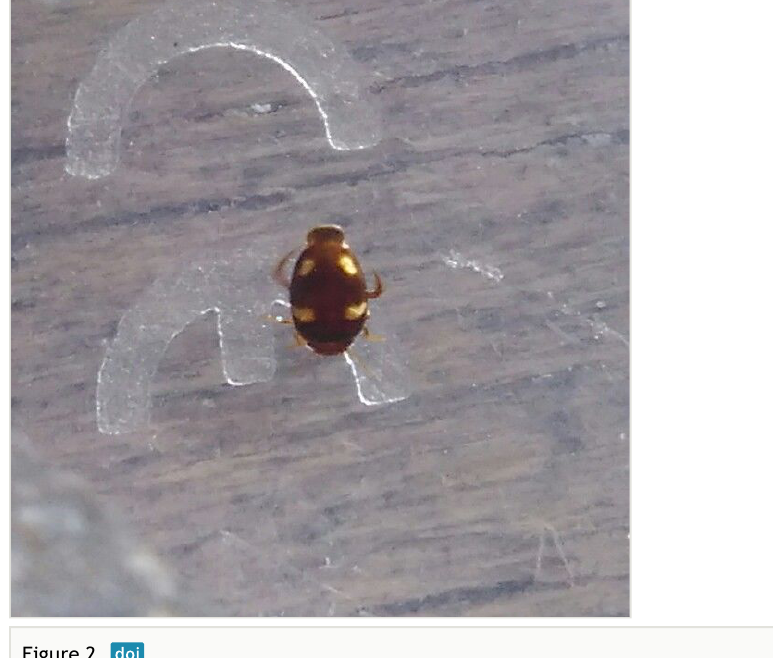
Allopachria quadripustulata , HP image from